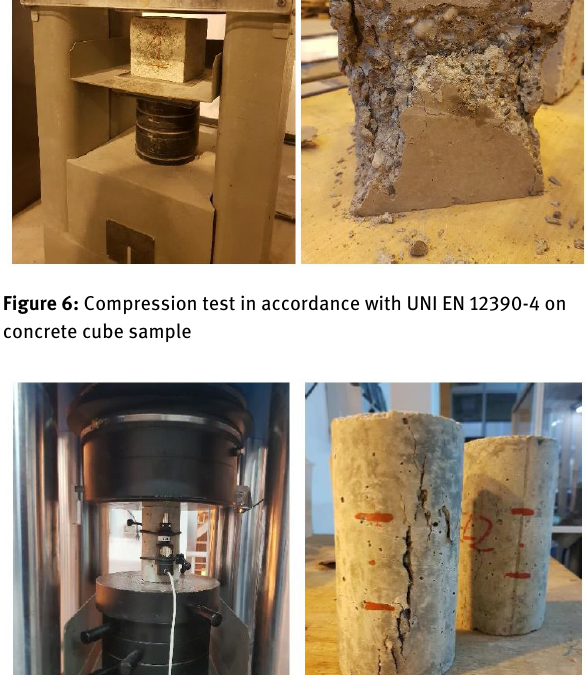
Figure 10: Typical crack patterns at failure of the medium-strength concrete columns with different arrangements of transverse rein-